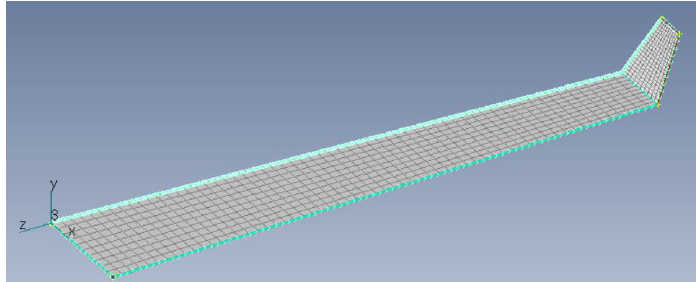
Figure 8. Wing with winglet aerodynamic